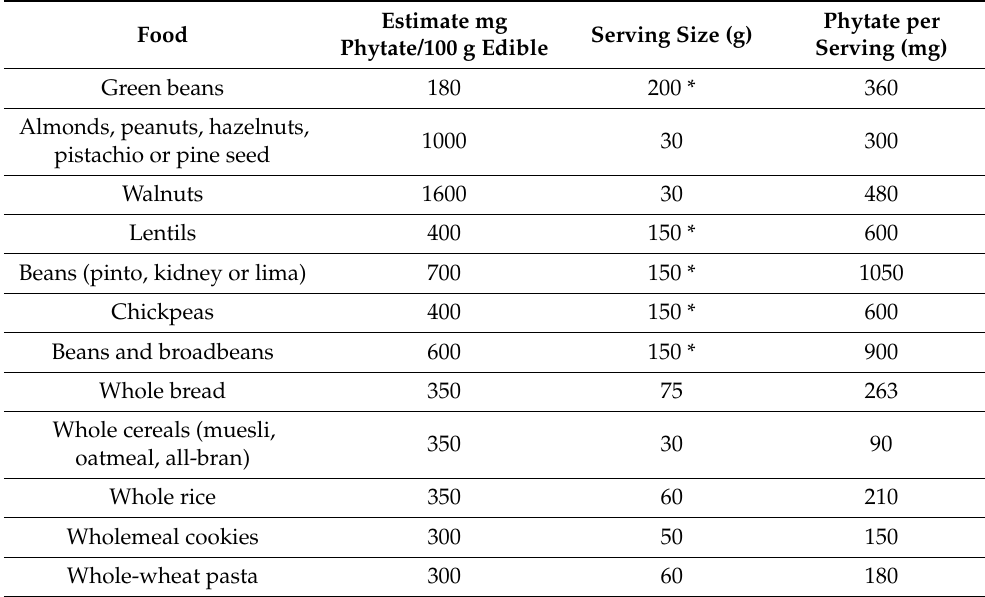
Table 1. Estimated phytate content for standard serving sizes, based on the reported phytate content for selected items in the food frequency questionnaire (FFQ)